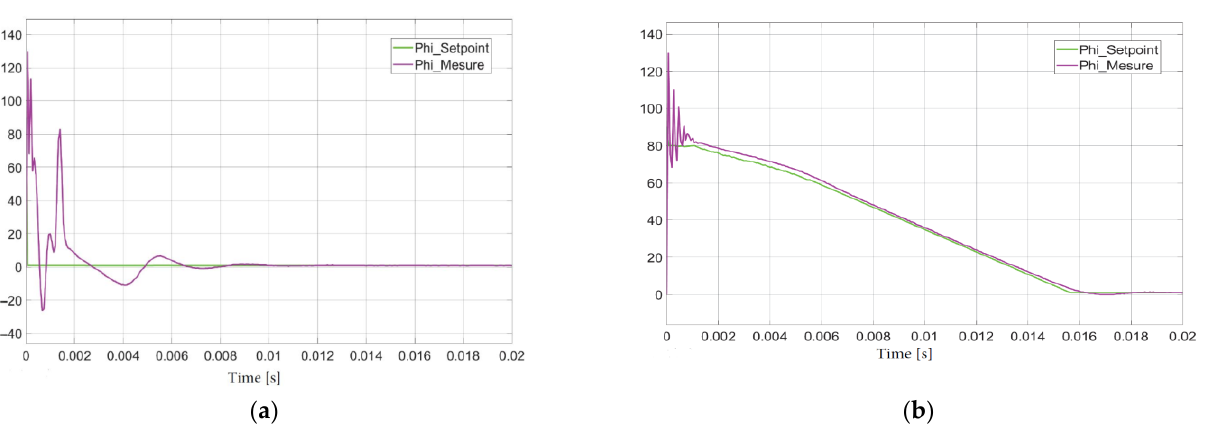
Figure 13. Values of 𝜑 𝑝 & 𝜑 𝑝∗ [°]: ( a ) without soft-start algorithm integrated; ( b ) with soft-start al- gorithm integrated.